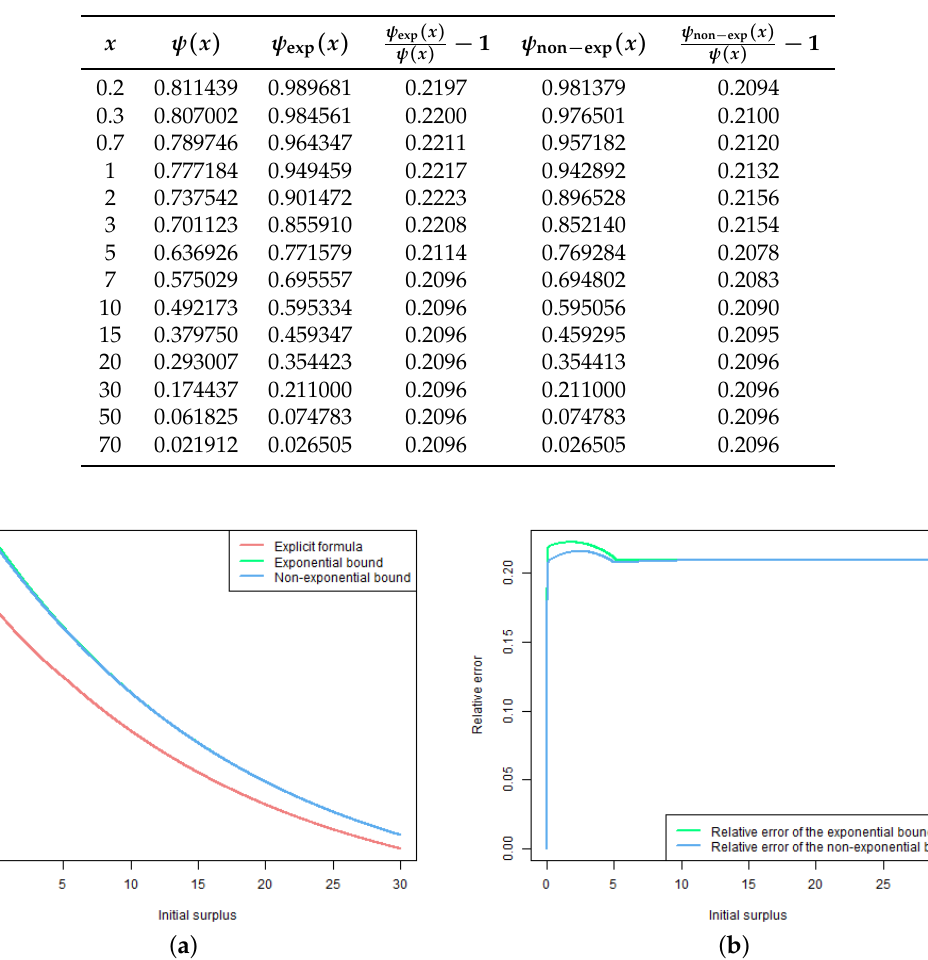
Table 2. Results of computations for the model considered in Example 2.